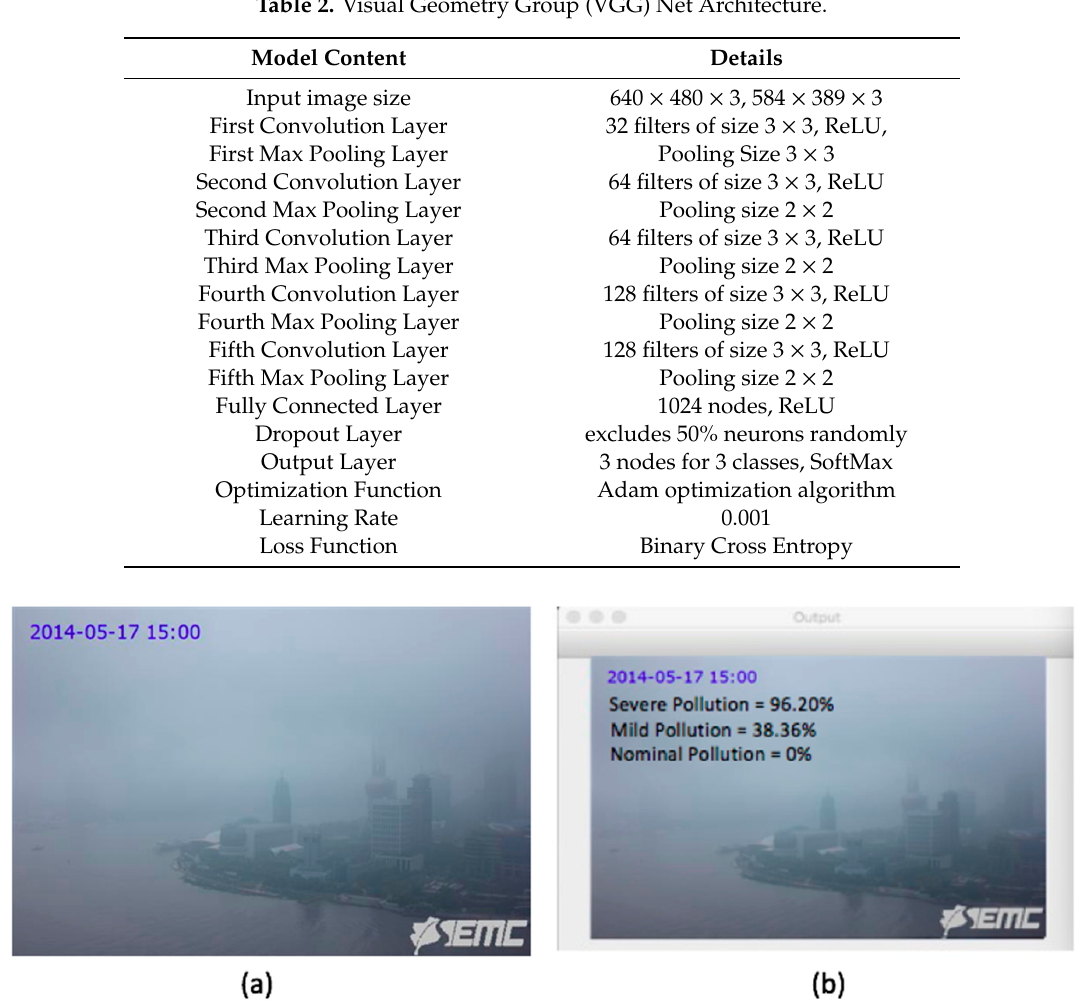
Table 2. Visual Geometry Group (VGG) Net Architecture.